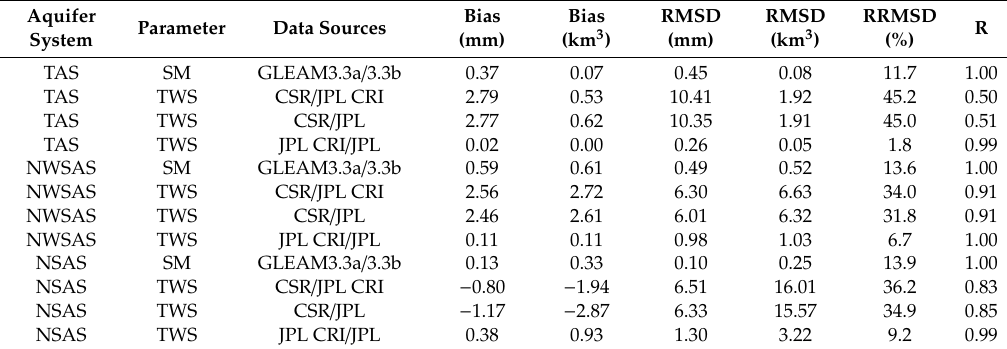
Table 1. Statistical results (bias, RMSD, RRMSD and R) of the comparison between the di ff erent products used for soil moisture (SM) (Global Land Evaporation Amsterdam Model (GLEAM) 3.3a and